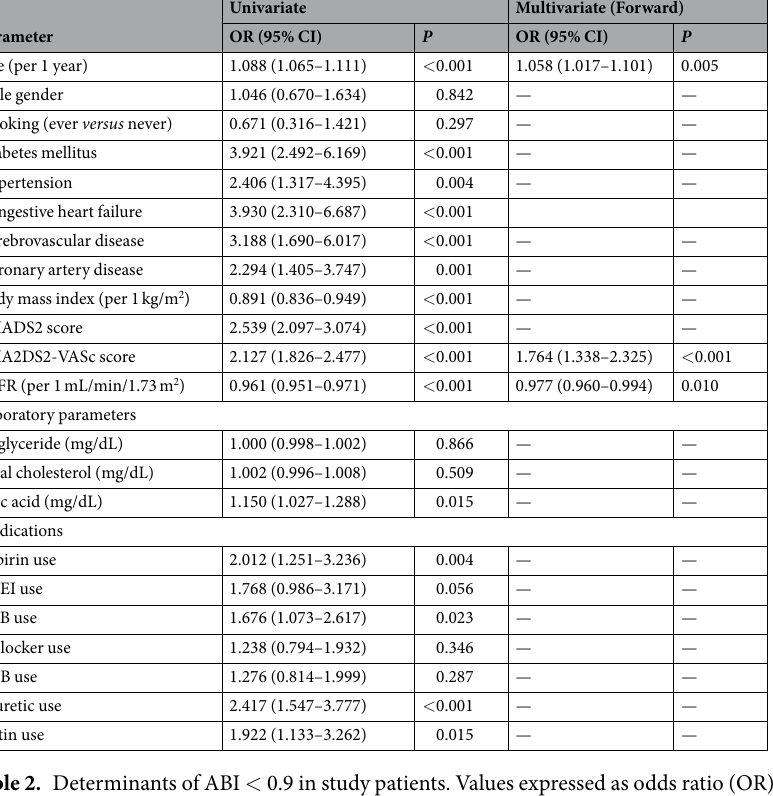
Table 2. Determinants of ABI < 0.9 in study patients. Values expressed as odds ratio (OR) and 95% confidence interval (CI). Abbreviations are the same as in Table